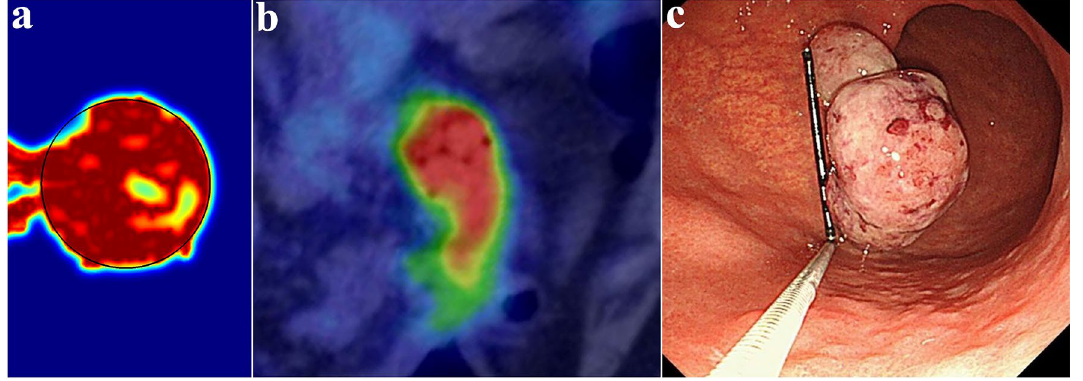
Figure 9. Qualitative validation of simulation results. ( a ) Synthetic PET image generated by the current mathematical model; ( b ) [ 18 F]FDG PET imaging shows high uptake of [ 18 F]FDG, suggesting the possibility of advanced gastric cancer 80 ; ( c ) Upper gastrointestinal endoscopy image shows a large (3.5 cm) pedunculated polyp-shaped gastric cancer with prolapse into the duodenal bulb 80 . (Sections ( b ) and ( c ) are used with permission from Suzuki et al. 80